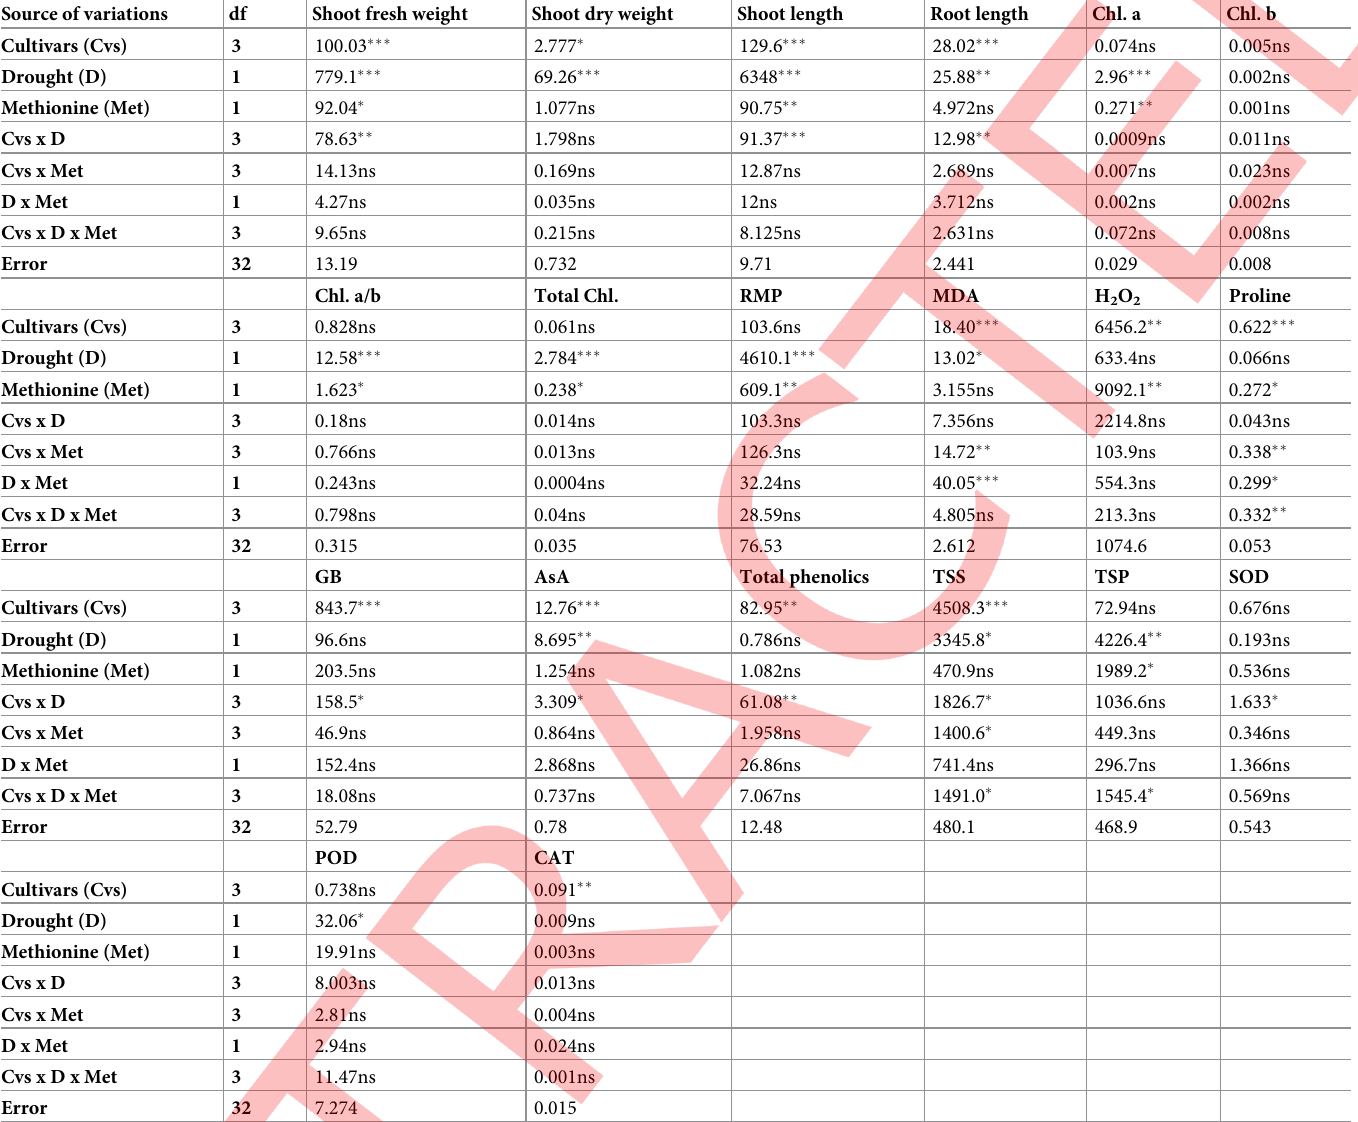
Table 1. Mean squares values (ANOVA) for growth, chlorophyll and oxidative defense system of four cultivars of sunflower ( Helianthus annuus L.) treated with foliar application of L-methionine (Met) grown under water-deficit stress. Source of